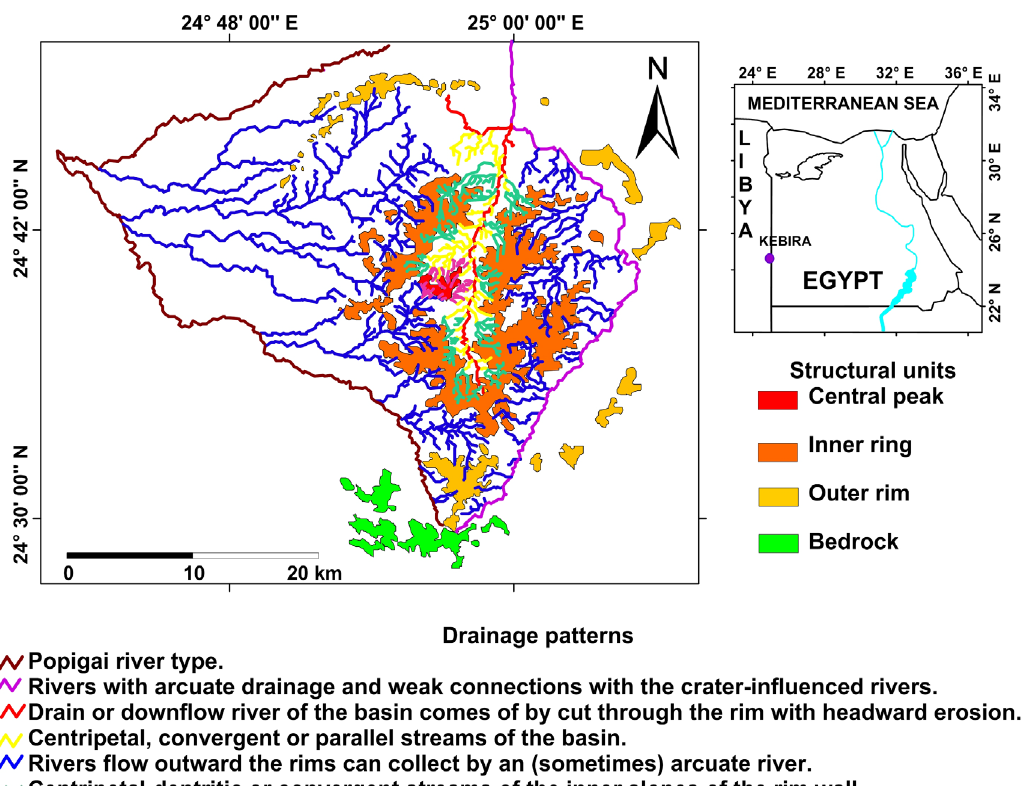
Figure 11. Drainage pattern of the Kebira structure. Structural units of the Kebira were proposed in [23].